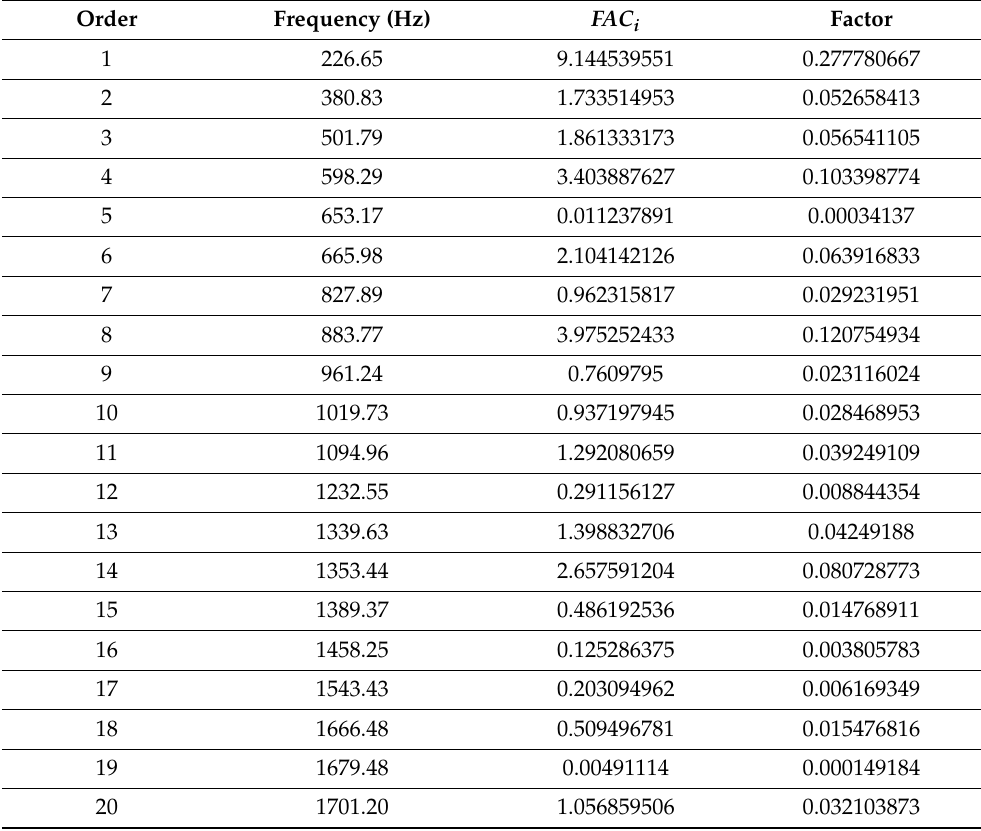
Figure 10. The weighted summation strain energy of the first 20 modes of the composite beam. Table 1. Each order modal frequency, modal participation factor and weight